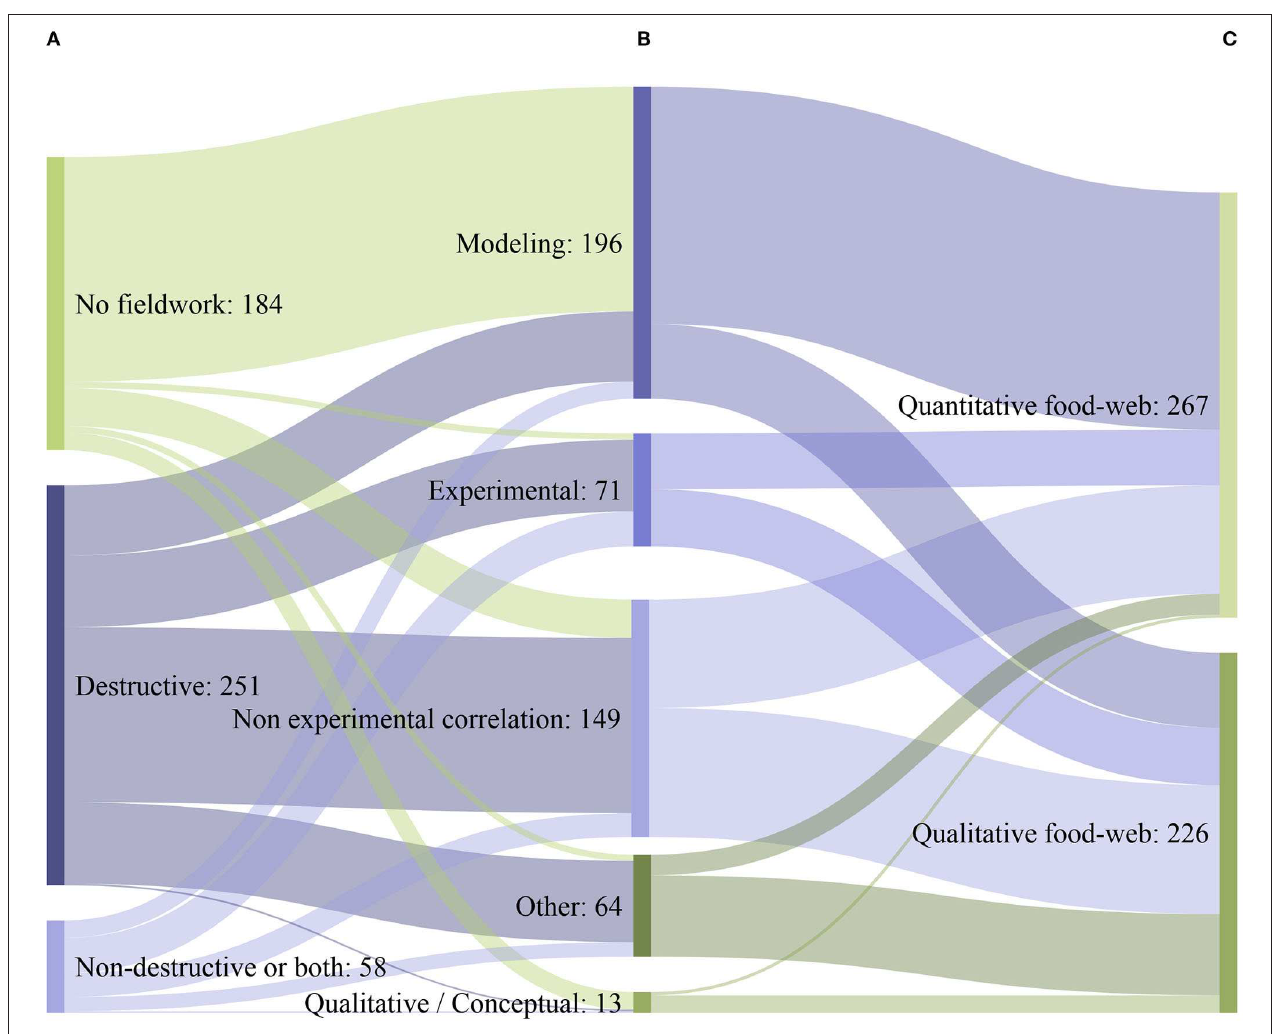
FIGURE 6 | Sankey diagram depicting the flow between (A) the different data acquisition methods (B) the main methodological approaches used to assess marine coastal shelf food webs, (C) the type of information (Quantitative/ Qualitative) provided by the studies ( N = 493). Lines and ribbons represent flows between two consecutive grouping bars only (A–B, B–C) . Non-destructive or both: exclusive use of non-destructive methods alone and combined use of both destructive and non-destructive